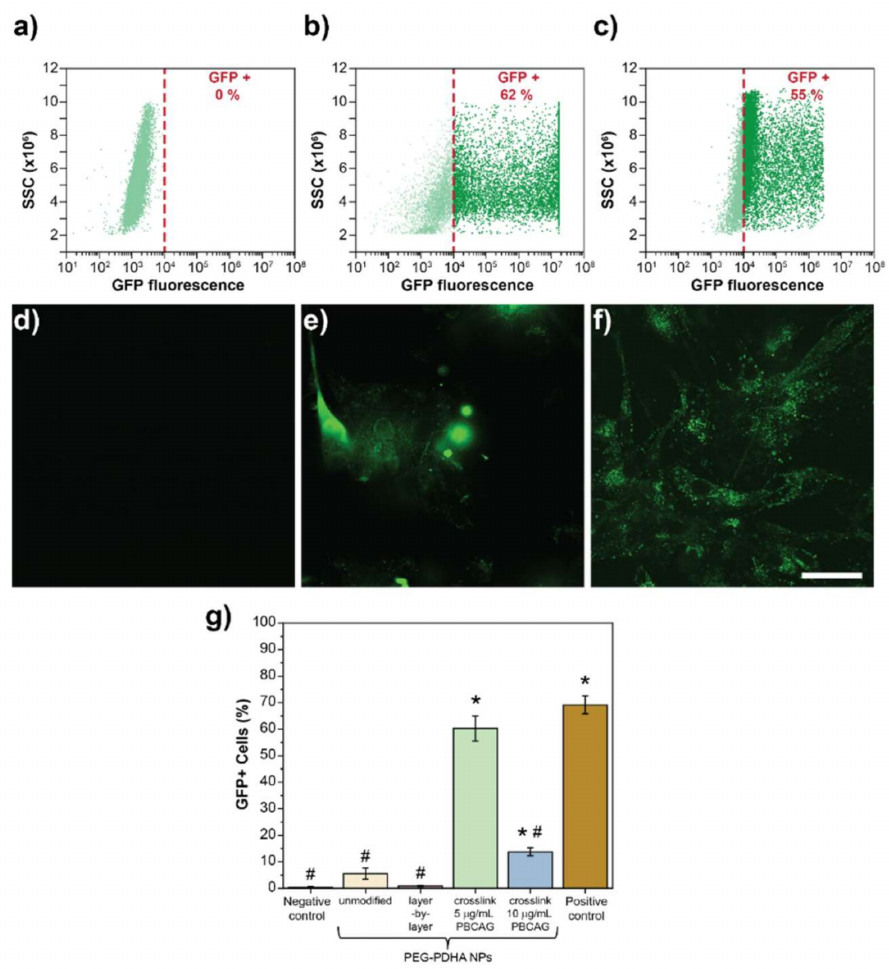
Figure 7. GFP expression on human glioblastoma (U87MG) cells as an indicator of PBCAG transfec- tion. GFP expression on U87MG cells quantified by flow cytometry and their corresponding confocal microscopy image 72 h post-treatment for: ( a , d ) intact cells (negative control); ( b , e ) cells co-cultured with Lipofectamine 3000 carrying 5 µ g of PBCAG (positive control); and ( c , f ) cells co-cultured with PEG-PDHA NPs carrying 5 µ g of PBCAG. Scale bar = 50 µ m. ( g ) Summarized GFP expression after PEG-PDHA nanoformulations and Lipofectamine 3000 transfection of PBCAG. Error bars represent standard deviation ( n = 4). ANOVA test was performed to determine statistical significance. * indi- cates statistical difference with negative control and # indicates statistical difference with positive control ( p -value <